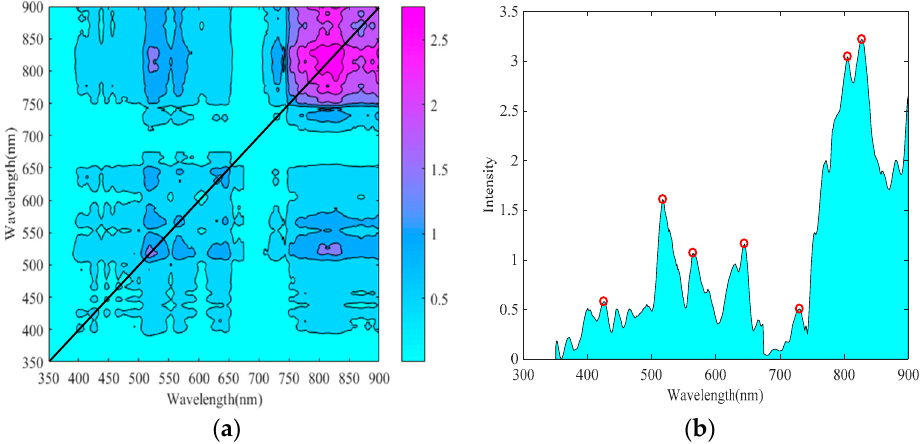
Figure 5. 2D correlation spectra of the winter wheat canopy for the jointing period: ( a ) Synchronous 2D spectra contour map; ( b ) diagonal of the synchronous contour map.